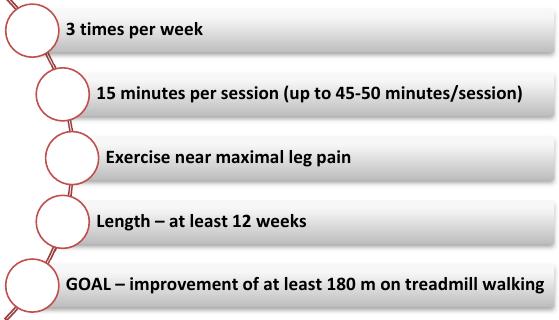
Figure 3. Key elements of an exercise training program.